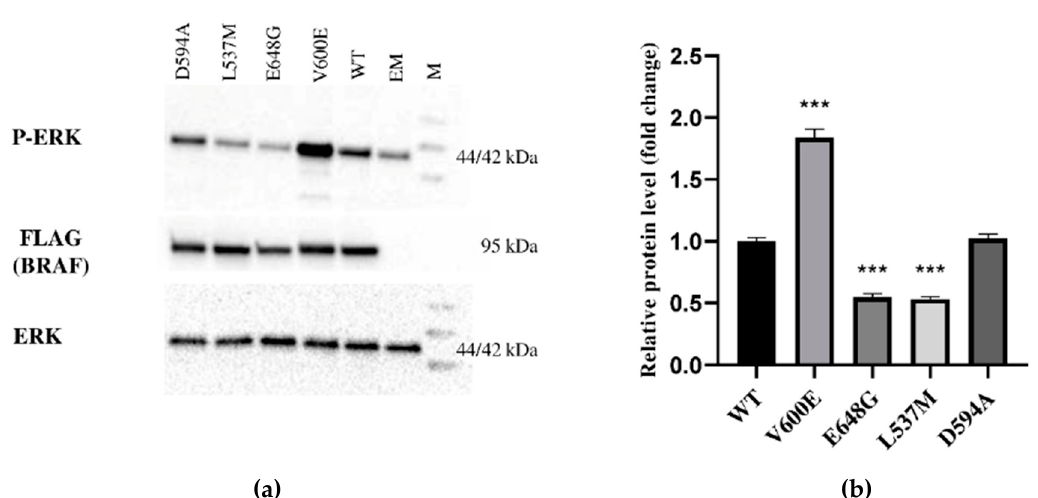
Figure 2. Protein expression measured by Western blot. ( a ) Expression of ERK-phosphorylated (P-ERK), FLAG (BRAF), and ERK proteins in THLE-2 cells overexpressed with p3XFLAG-CMV empty plasmid (EM), or plasmid containing BRAF WT (WT) and BRAF mutations (V600E, E648G, L537M, D594A). The density of each band was quantified by ImageJ software ( b ) The protein expression level was normalized to FLAG (BRAF) and presented as a fold change (±SD) of band intensity in the presented blot. The experiment was conducted in four independent replicates ( n = 4) and analyzed using a one-way analysis of variance (ANOVA) with Bonferroni correction, *** p < 0.001. The expression of ERK proteins was equal for all samples. M—protein marker 10–245 kDa.